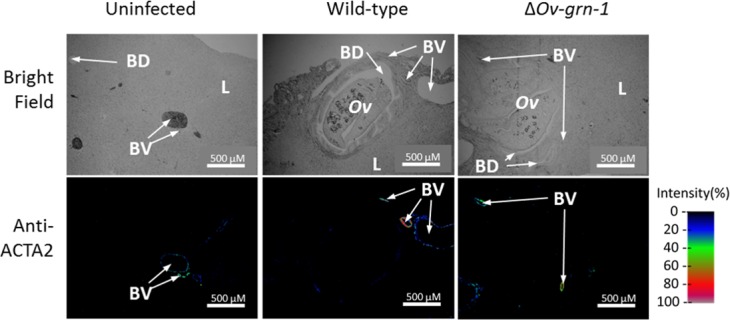
Representative wide-angle view of anti-ACTA2 immunofluorescence and bright field liver sections.Thin liver sections presented in bright field or under fluorescent light following probing with anti-ACTA2 antibody; fluorescence intensity is indicated on a blue/green/red scale. These images were used to construct the bright field, immunofluorescence overlay and zoomed images in Figure 4D.